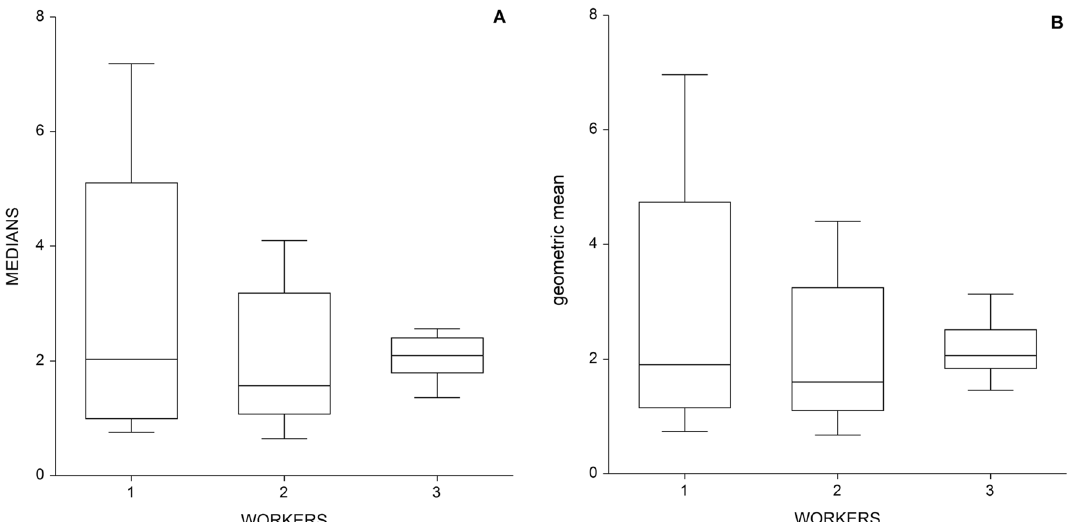
Figure 2. The median ( A ) and geometric mean ( B ) concentrations of respirable PM in three included